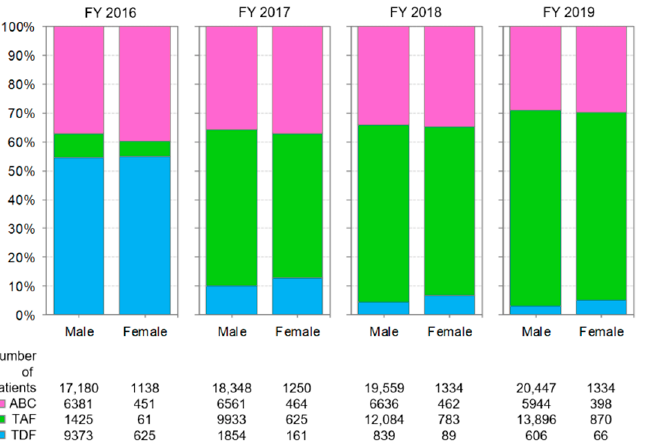
Figure 6. Changes in the prescriptions of backbone drugs by sex. The analysis was performed on drugs listed in Table 1. ABC: abacavir, TAF: tenofovir alafenamide fumarate, TDF: tenofovir disoproxil fumarate.